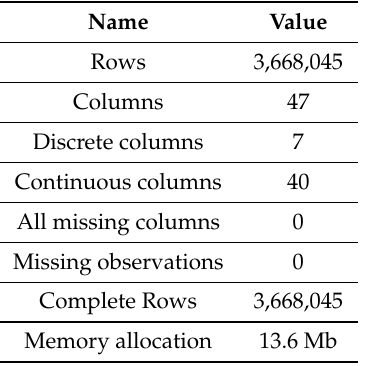
Table 3. Statistical Description for The Dataset.